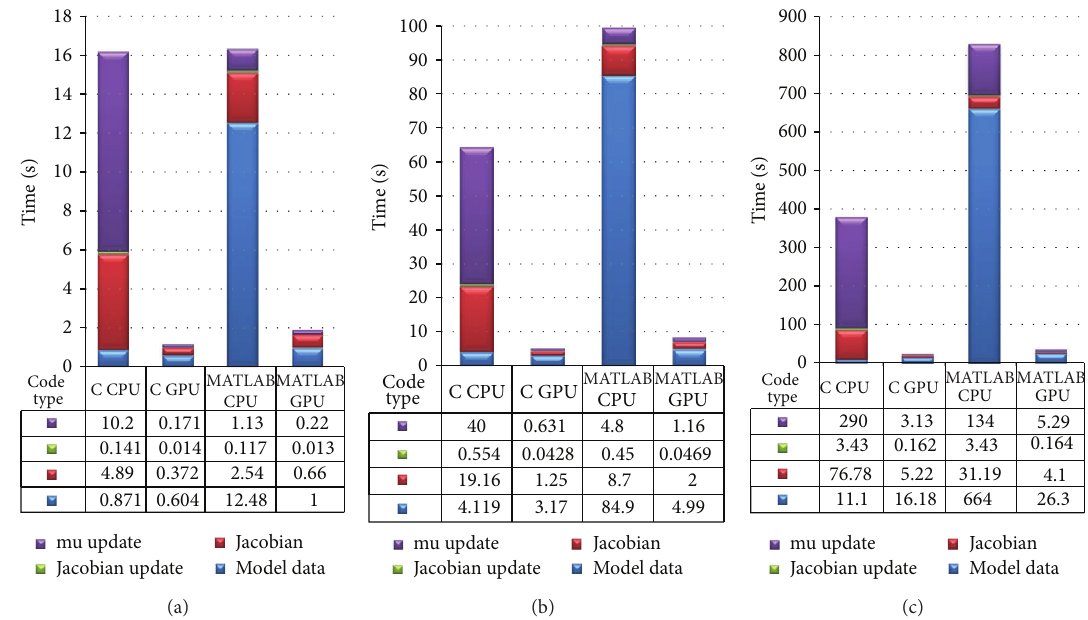
Figure 9: Breakup of the execution time of various computing blocks of the algorithm on C CPU, C GPU, MATLAB CPU, and MATLAB GPU platforms for mesh size (a) 3736, (b) 7465, and (c) 15031.